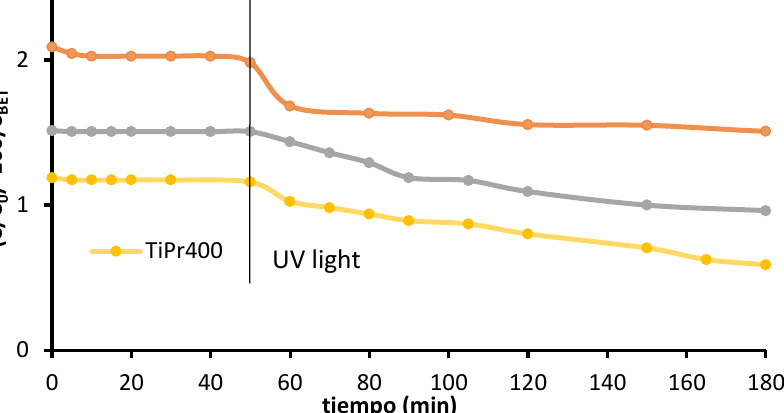
Figure 7. Curves of degradation %/S BET vs. time. The vertical line indicates switch on of the UV lamp.